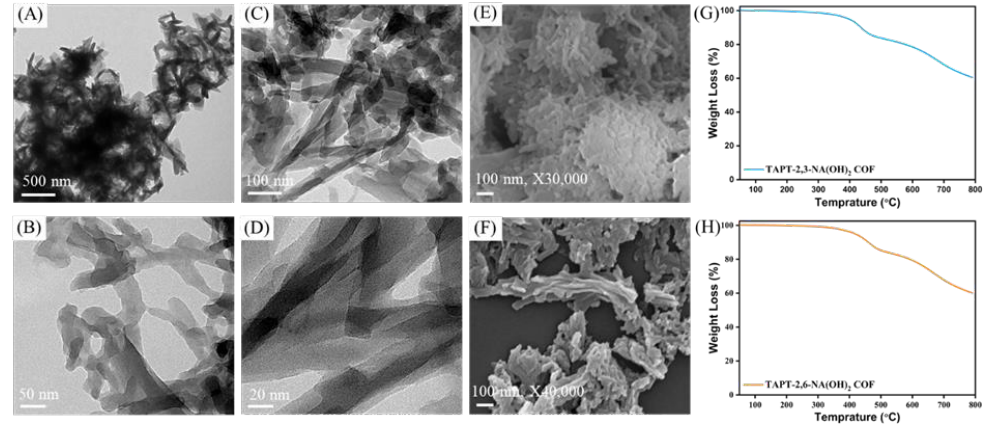
Figure 4. ( A – D ) TEM images of ( A , B ) TAPT-2,3-NA(OH) 2 and ( C , D ) TAPT-2,6-NA(OH) 2 COFs, measured at different magnifications. ( E , F ) FE-SEM images of ( E ) TAPT-2,3-NA(OH) 2 and ( F ) TAPT-2,6-NA(OH) 2 COFs. ( G , H ) TGA curves of ( G ) TAPT-2,3-NA(OH) 2 and ( H ) TAPT-2,6-NA(OH) 2 COFs.